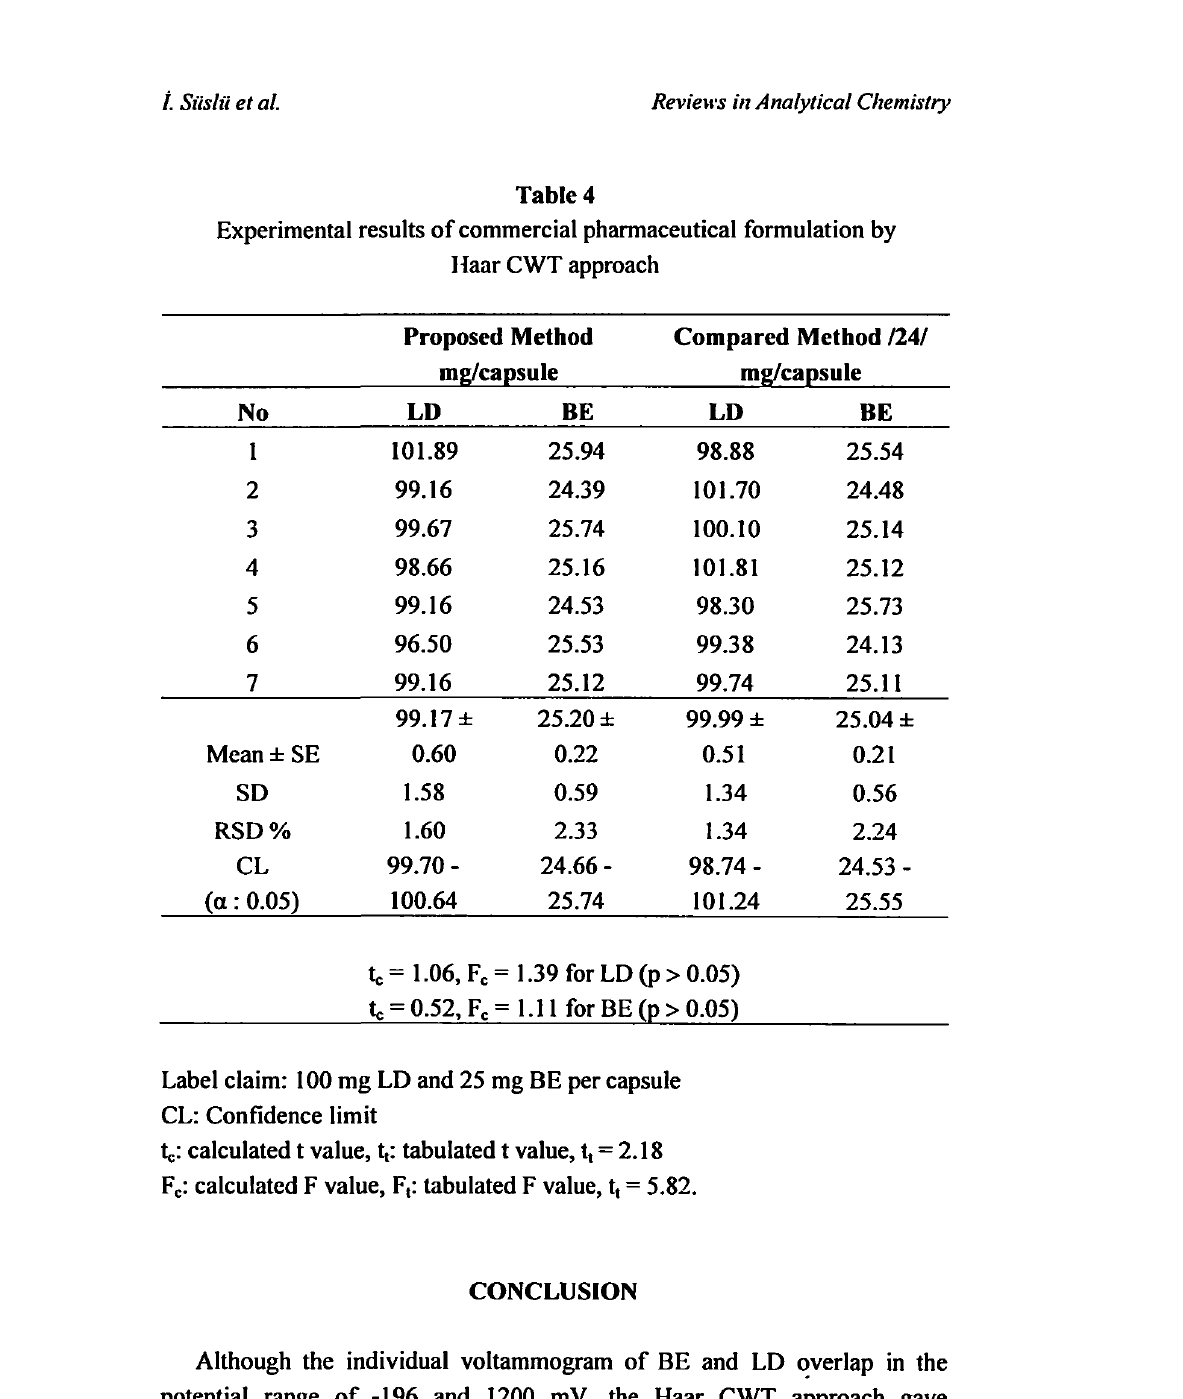
Experimental results of commercial pharmaceutical formulation by Haar CWT approach Proposed Method Compared Method 1241